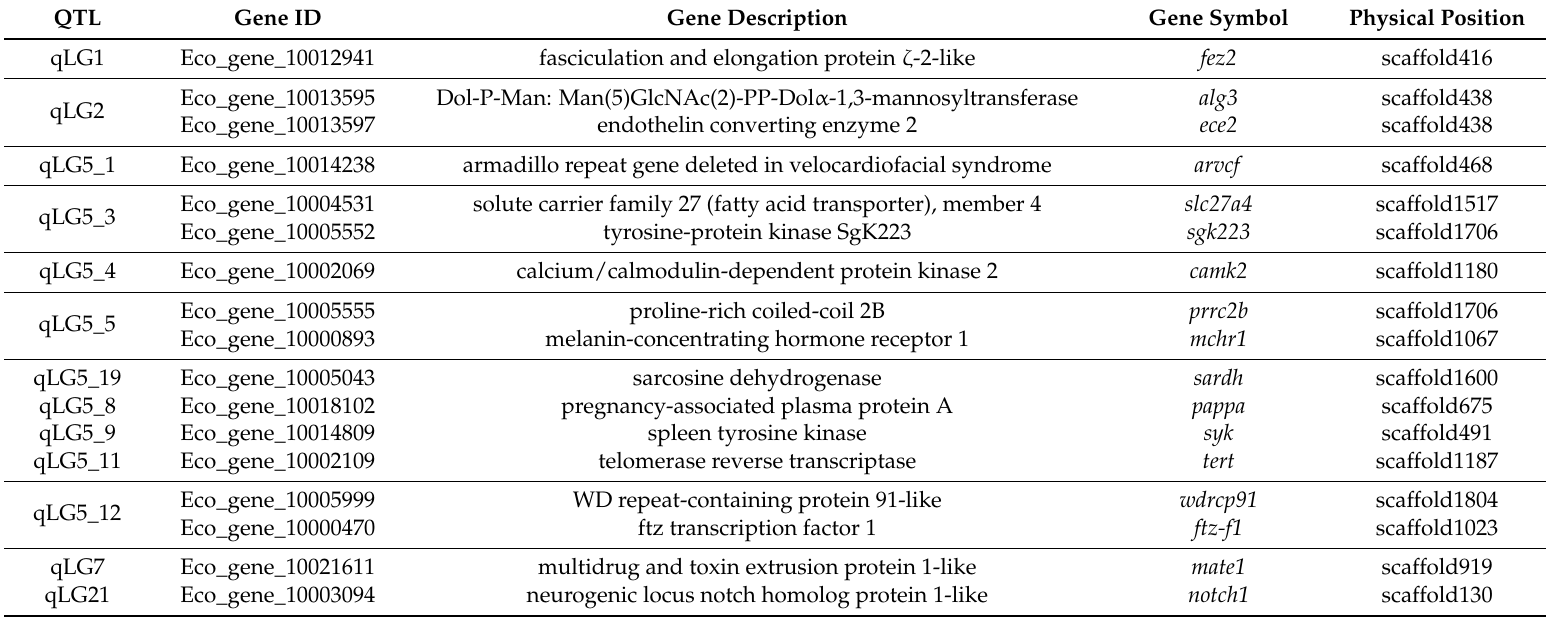
Table 2. Genes in the growth-related QTL of orange-spotted